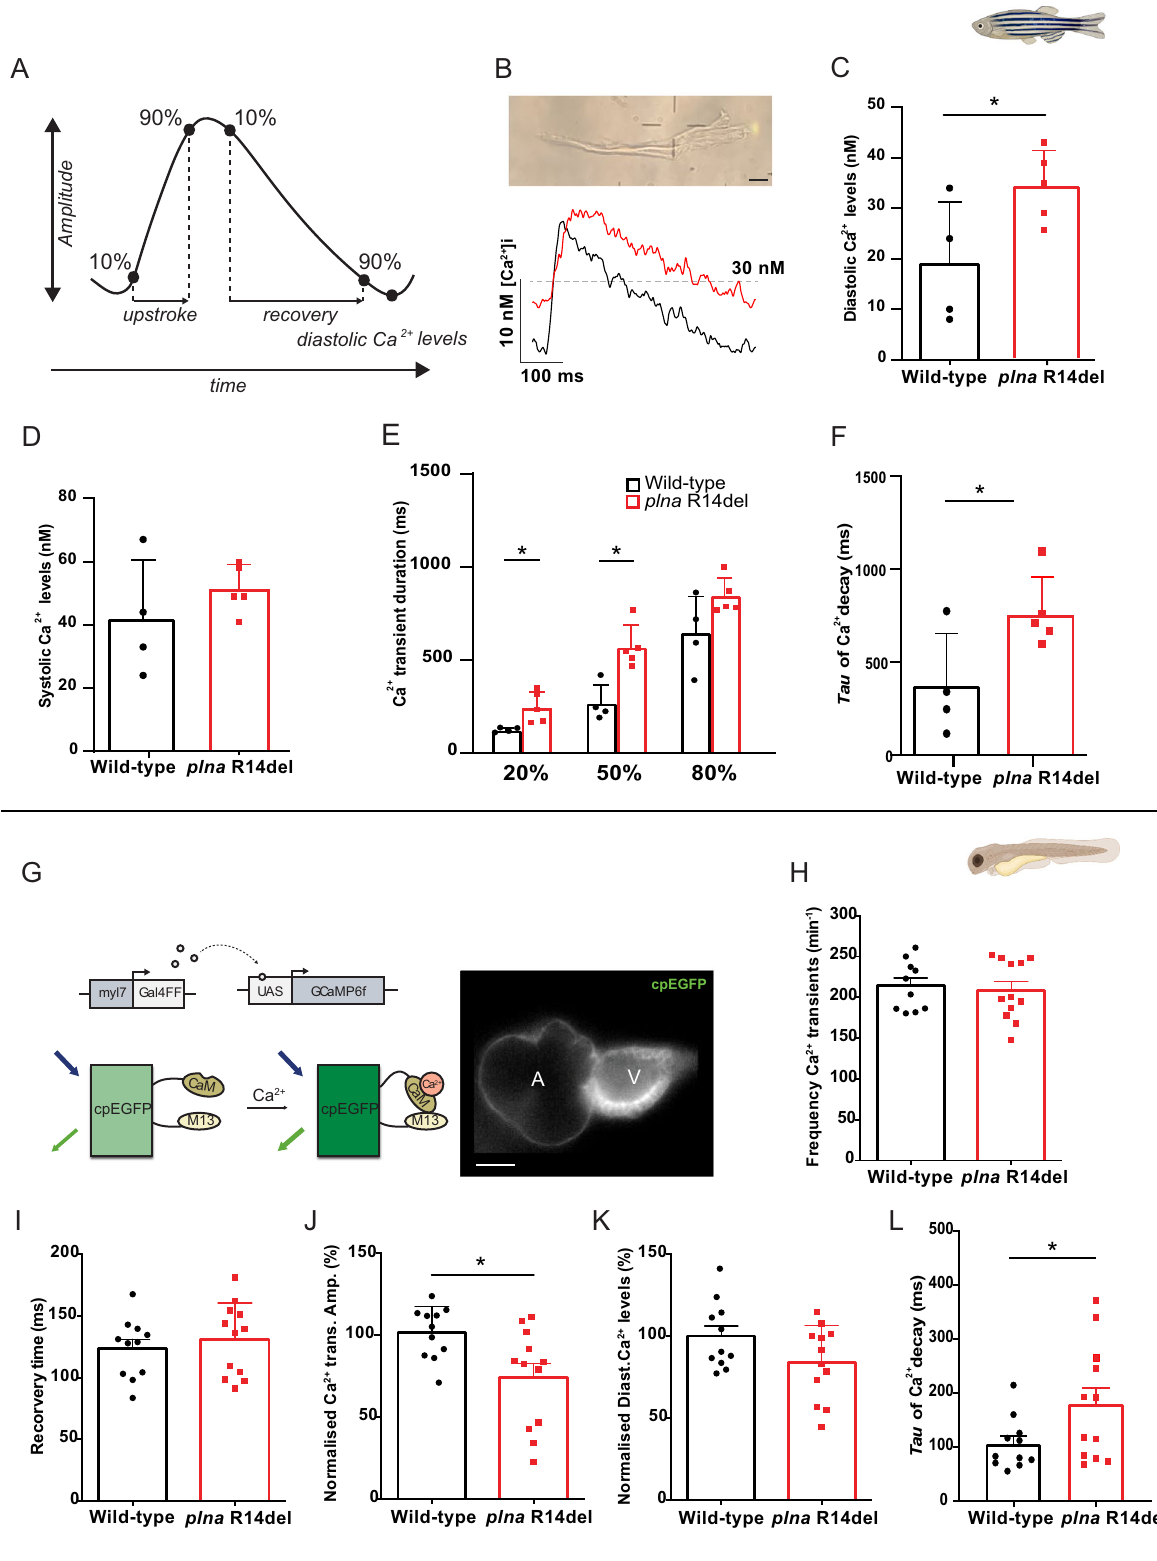
adult plna R14del cardiomyocytes, we performed patch clamp recordings on isolated ventricular cardiomyocytes. To this end, cardiomyocytes of adult wild type and plna R14del zebra fi sh hearts were measured at 1 and 4 Hz before and after treatment with istaroxime. Interestingly, istaroxime treatment resulted in